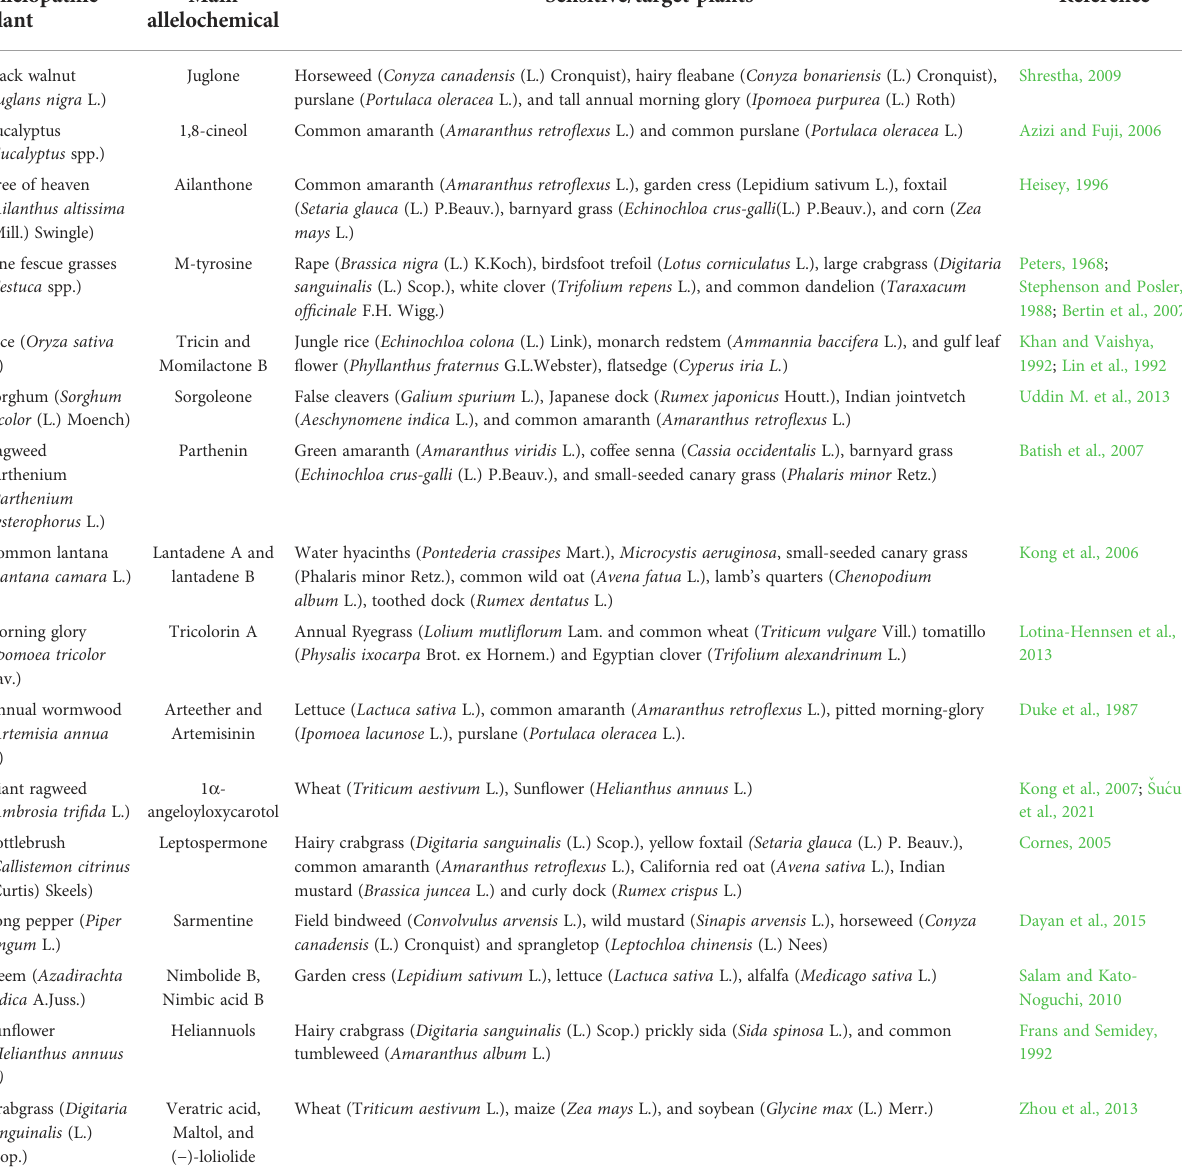
TABLE 1 Examples of allelopathic plants with their potent allelochemical against sensitive